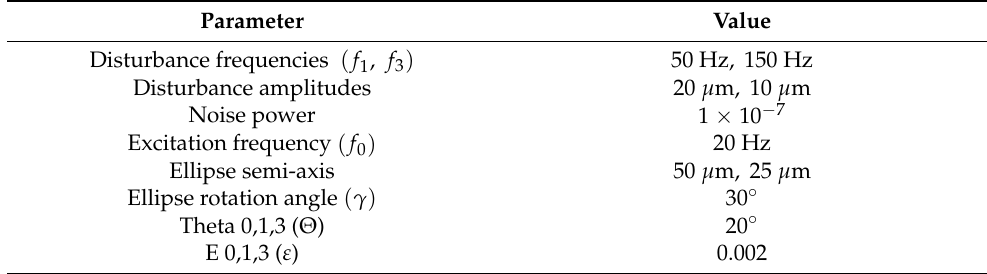
Table 2. The simulation parameters.